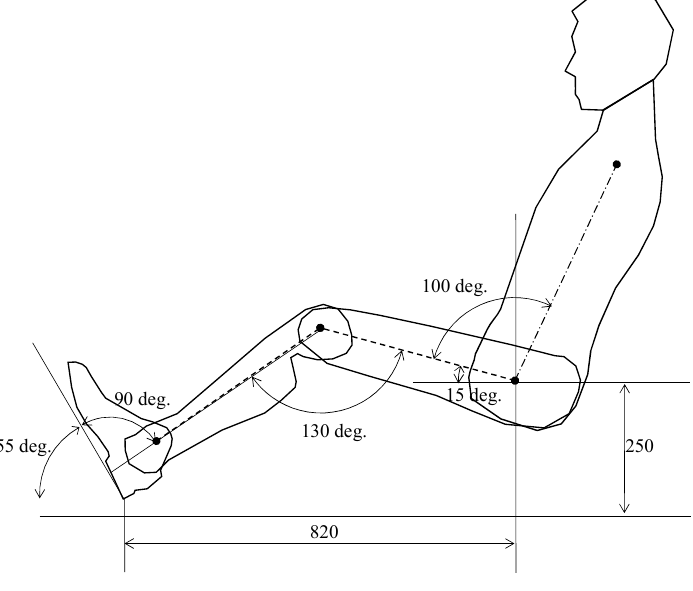
Figure 4. Sitting posture in the measurement.